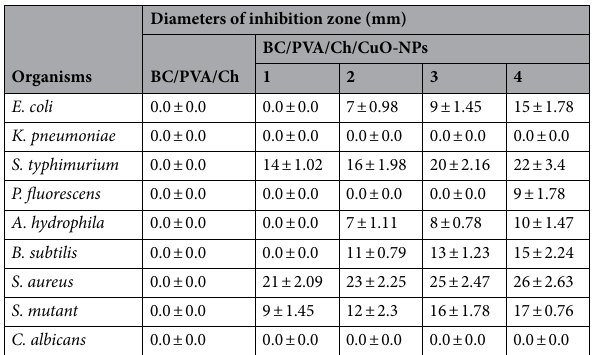
Table 3. The antimicrobial activity of the prepared BC/PVA/Ch/CuO-NPs composites at four CuO-NPs concentrations compared to BC/PVA/Ch (negative control) against nine pathogenic microorganisms. All values were expressed as Mean ± standard